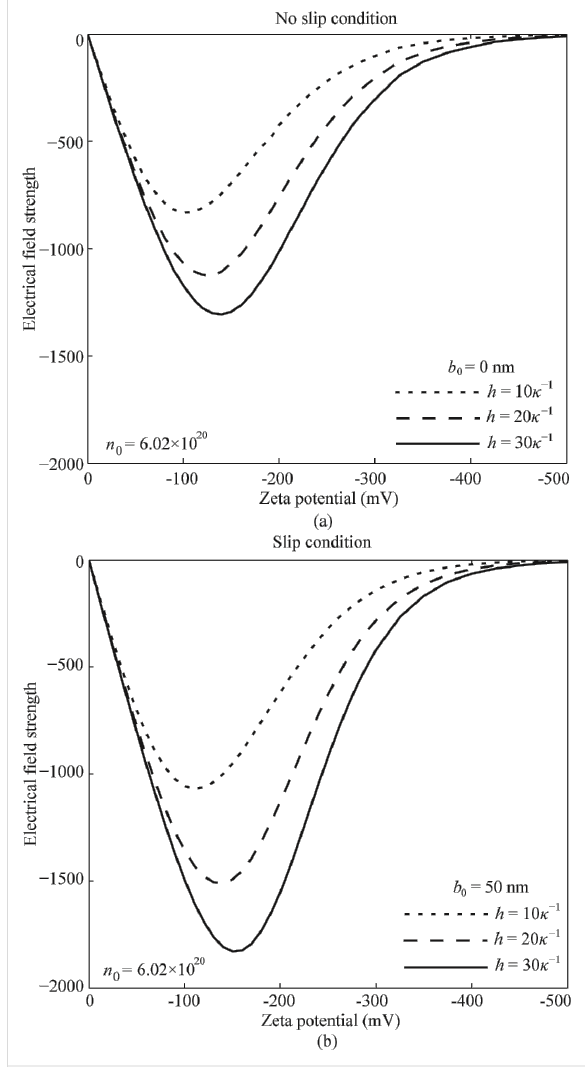
Figure 8: The effect of zeta potential on the electrical field strength of the pressure-driven fluid flow in the microchannel with no-slip condi- tion (a) and slip condition